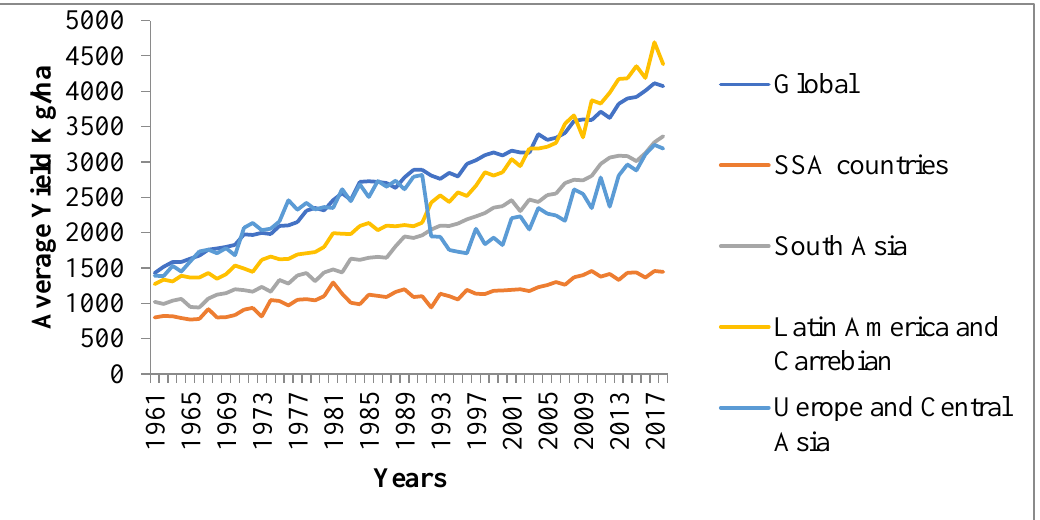
Figure 9. Average yield of cereal from 1961 to 2018 for different regions and the global average. Source: https://data.worldbank.org/indicator/AG.YLD.CREL.KG?locations=ZG. Accessed on 22 February